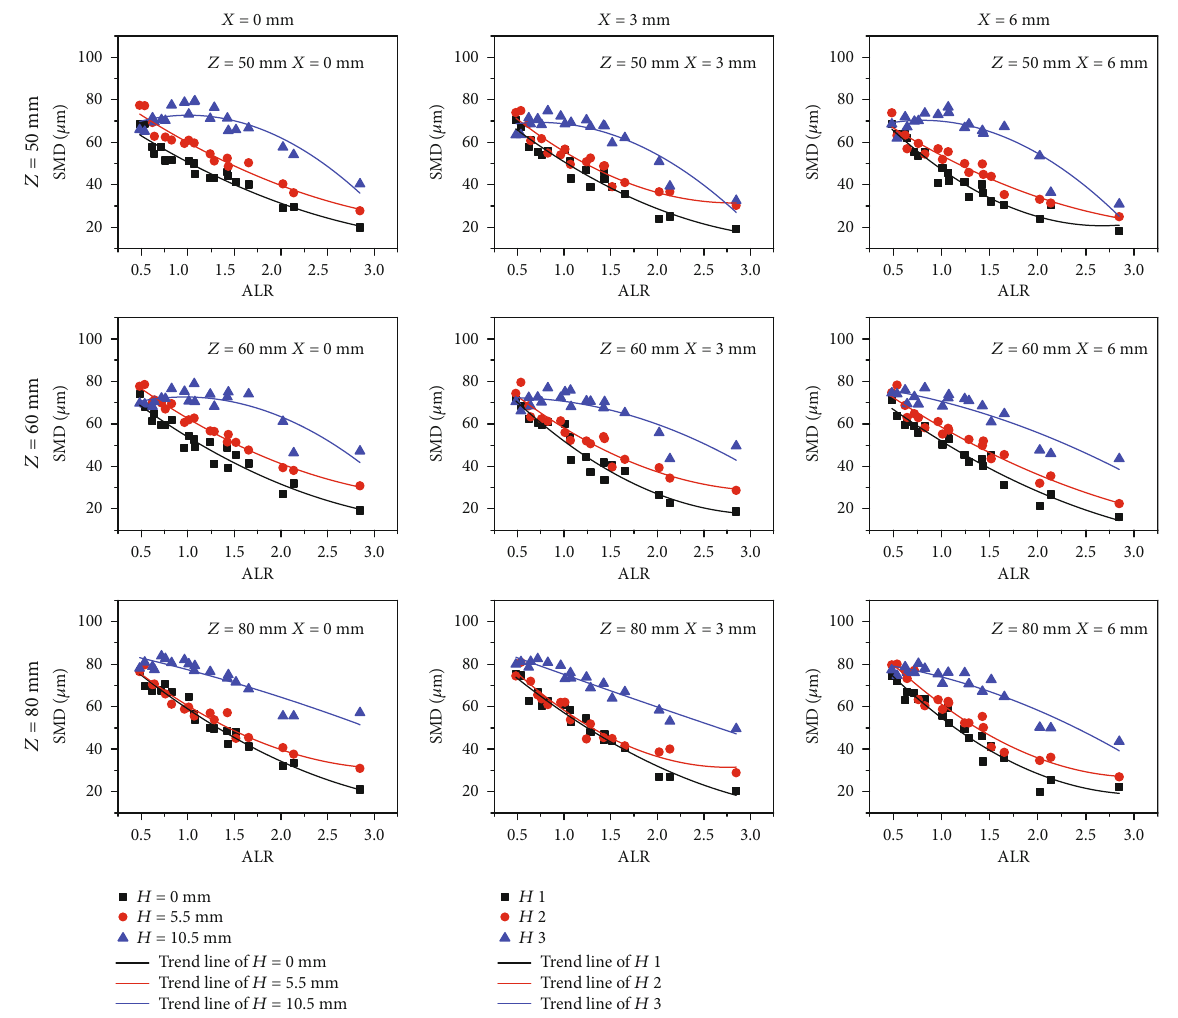
Figure 7: Comparison of SMD characteristics of H series nozzle at various downstream axial distances.